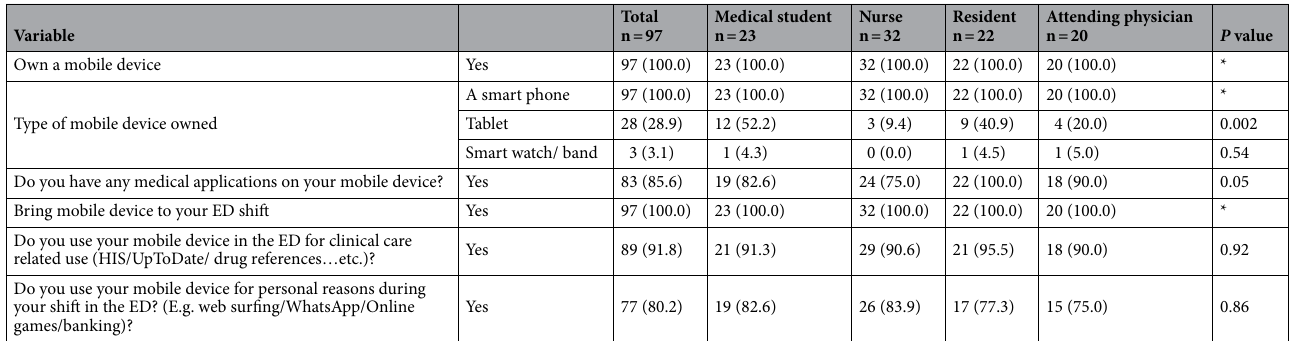
Table 2. Healthcare providers’ self-reported mobile device use stratified by HCP category a, b . *Indicates that a P value could not be obtained due to uniformity in the responses. a Cell counts may not add up to the raw total due to missing responses in the data. b Valid percentages were